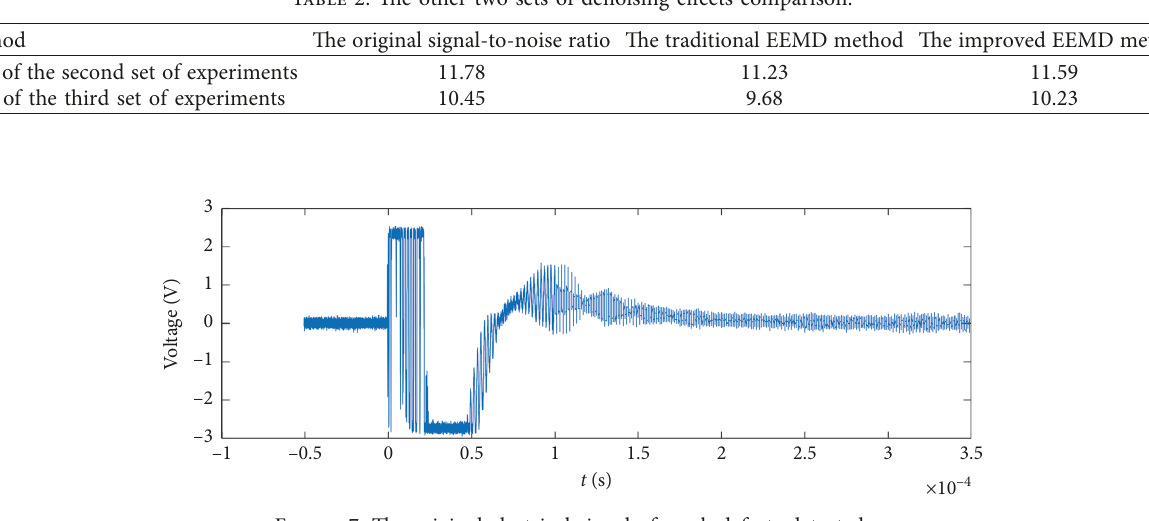
Figure 7: The original electrical signal of crack defects